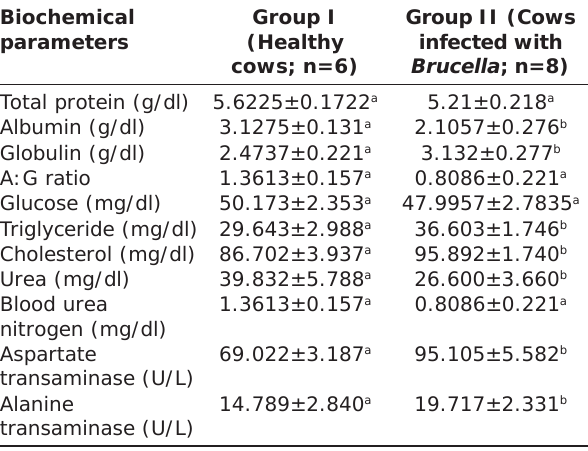
Table-1: Mean±Standard error of plasma biochemical parameters in healthy and Brucella infected cows. Biochemical